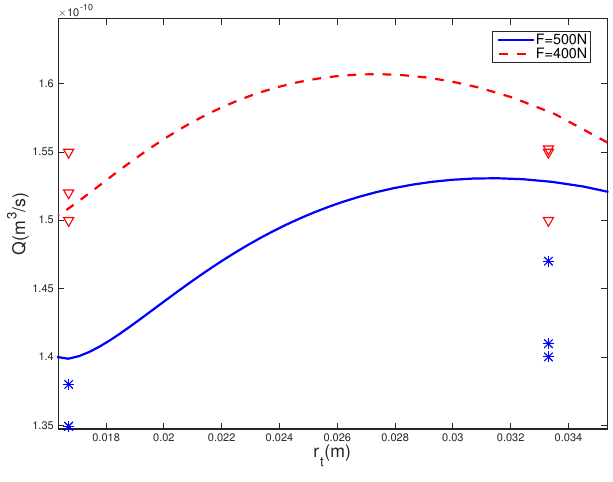
Figure 9. The leak rate versus the outer radius of the